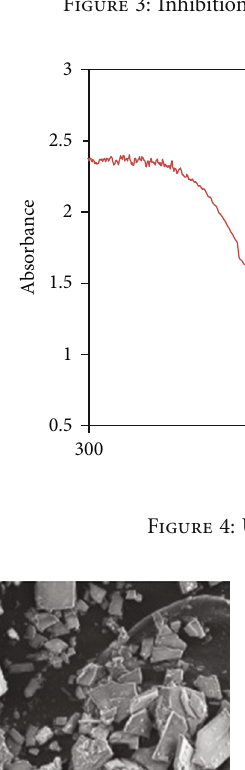
Figure 3: Inhibition of hydroxyl radical by star anise extract.